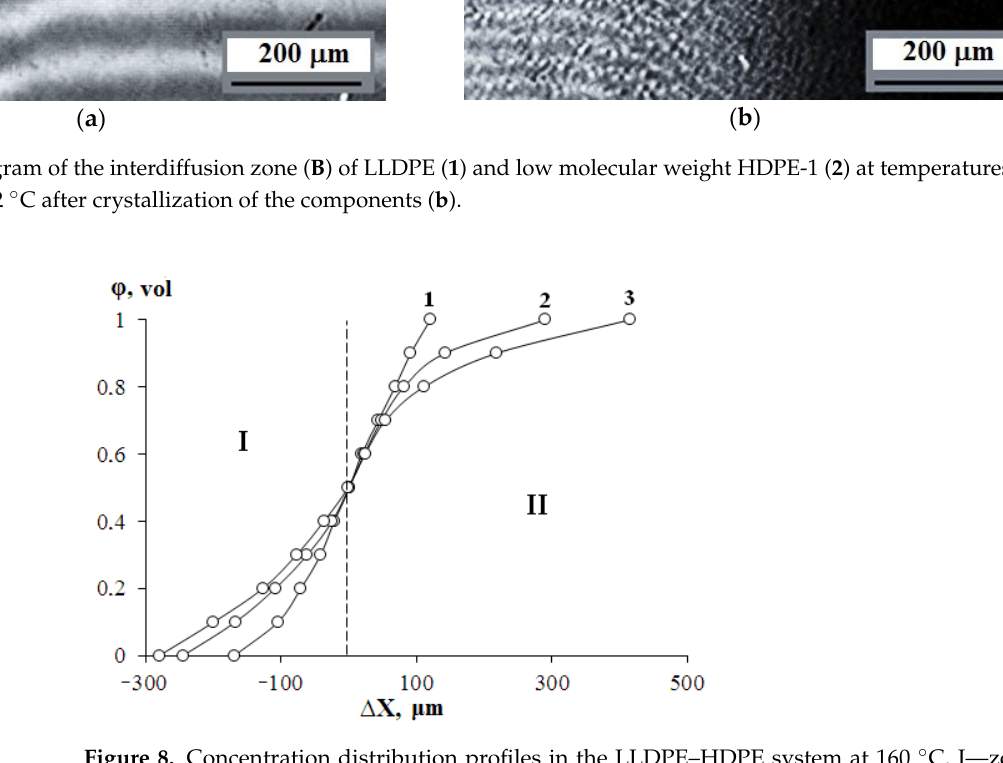
Figure 8. Concentration distribution profiles in the LLDPE–HDPE system at 160 °C. I—zone of HDPE-2 into LLDPE, II—zone of LLDPE into HDPE-2. Times: 1—225 min, 2—676 min, 3—1445 min. The dotted line indicates the position of the Boltzmann–Matano line. Volume fractions are calculated taking into account the density of polymers.